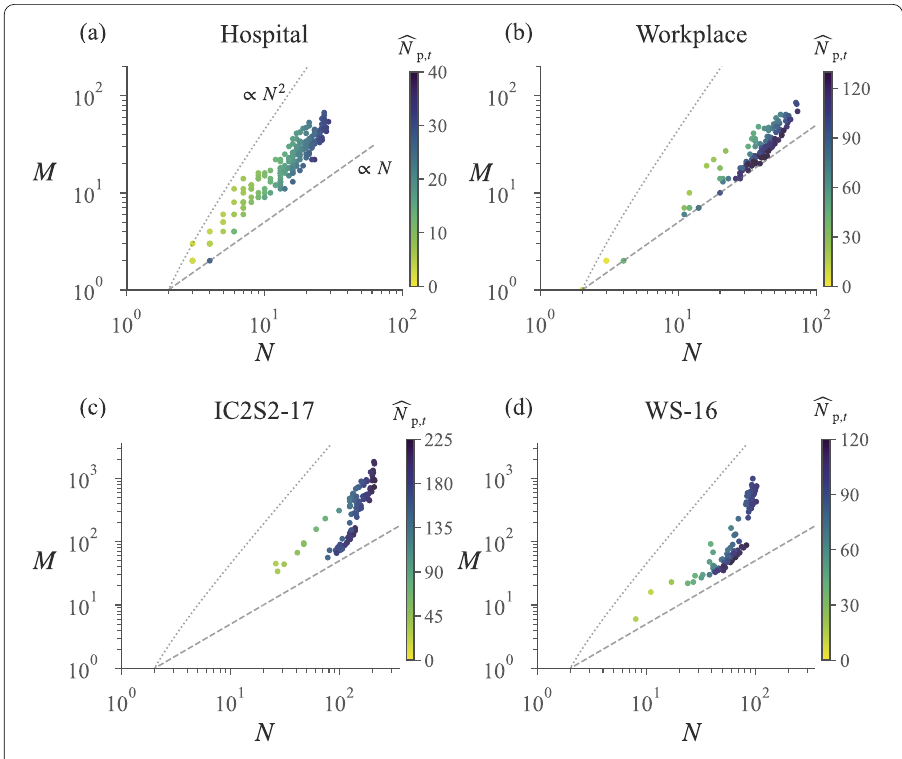
Figure 6 Densification scaling and changes in estimated population size in face-to-face networks. N - M scaling plots are shown for ( a ) Hospital on December 7, 2010 ( b ) Workplace on June 27, 2015 ( c ) IC2S2-17 on July 11, 2017 and ( d ) WS-16 on December 1, 2016. Each dot represents a snapshot of the network and colors denote estimated population size (cid:6) N p , t based on the respective color bar. Gray dashed and dotted lines show theoretical lower ( M = N /2) and upper ( M = N ( N – 1)/2) bounds. Estimates are based on Eq.